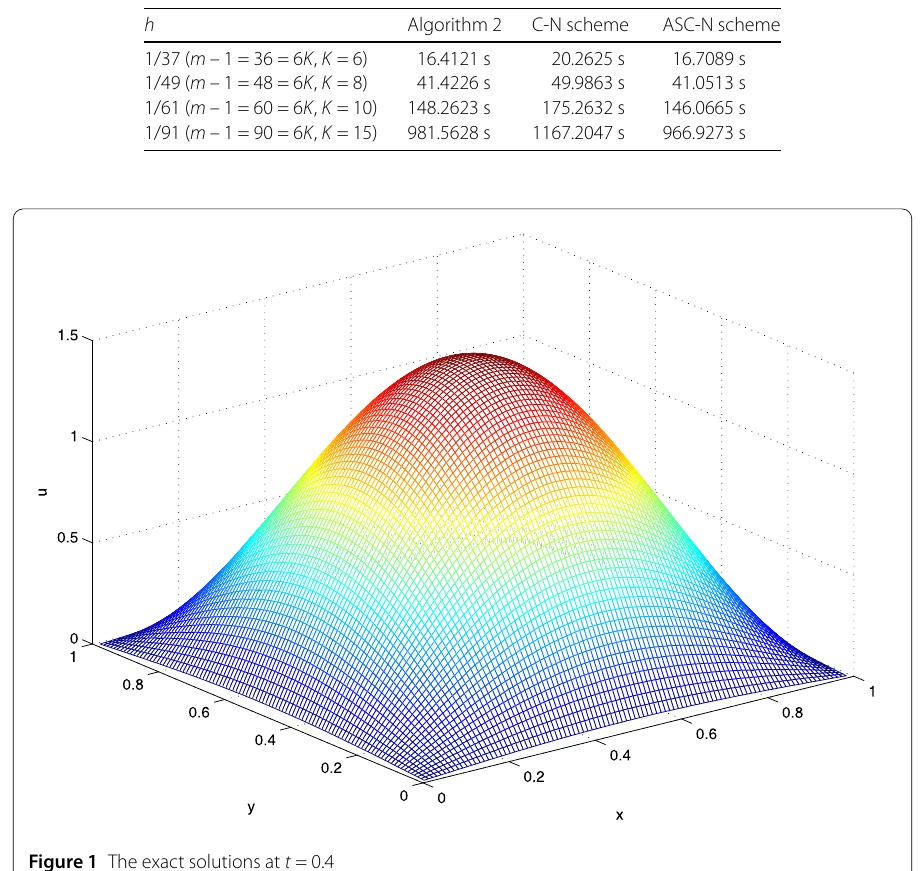
Table 8 Comparison of three schemes calculation time for r = 1.2 at t = 0.5